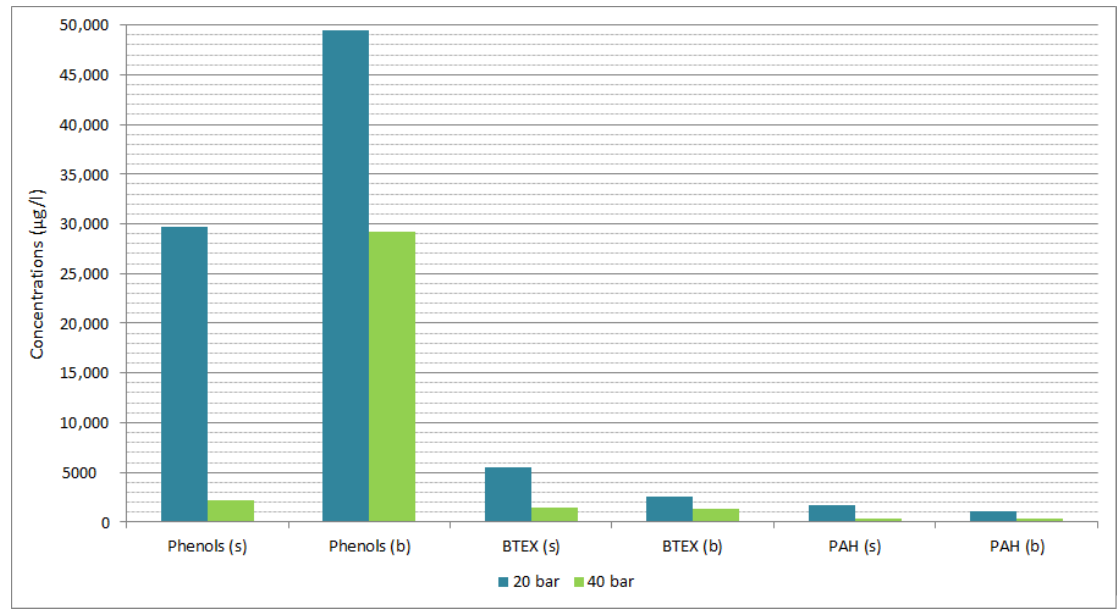
Figure 4. Comparison of selected wastewater organic contaminants from gasification of semi-anthracite and bituminous coal—pressure impact ((s)—semi-anthracite coal; (b)—bituminous